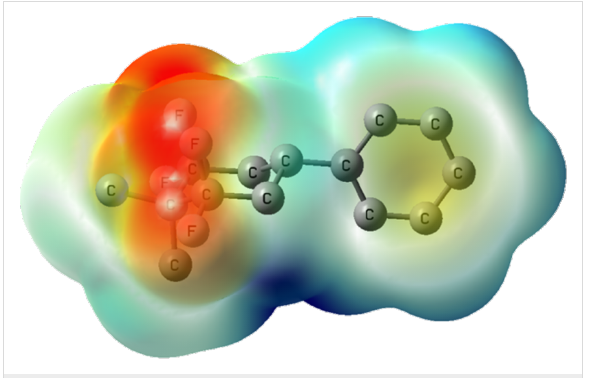
Figure 4: Electrostatic potential map for 4c calculated at the B3LYP/6- 311G(d,p) level for an optimised structure calculated at the B3LYP-D3/ 6-311+G(d,p) level. The image is plotted on a colour scale from − 0.003 a.u. (red) to +0.003 a.u. (blue) and mapped onto an isodensity surface ( ρ = 4 × 10 − 4 a.u.); hydrogen atoms are omitted for